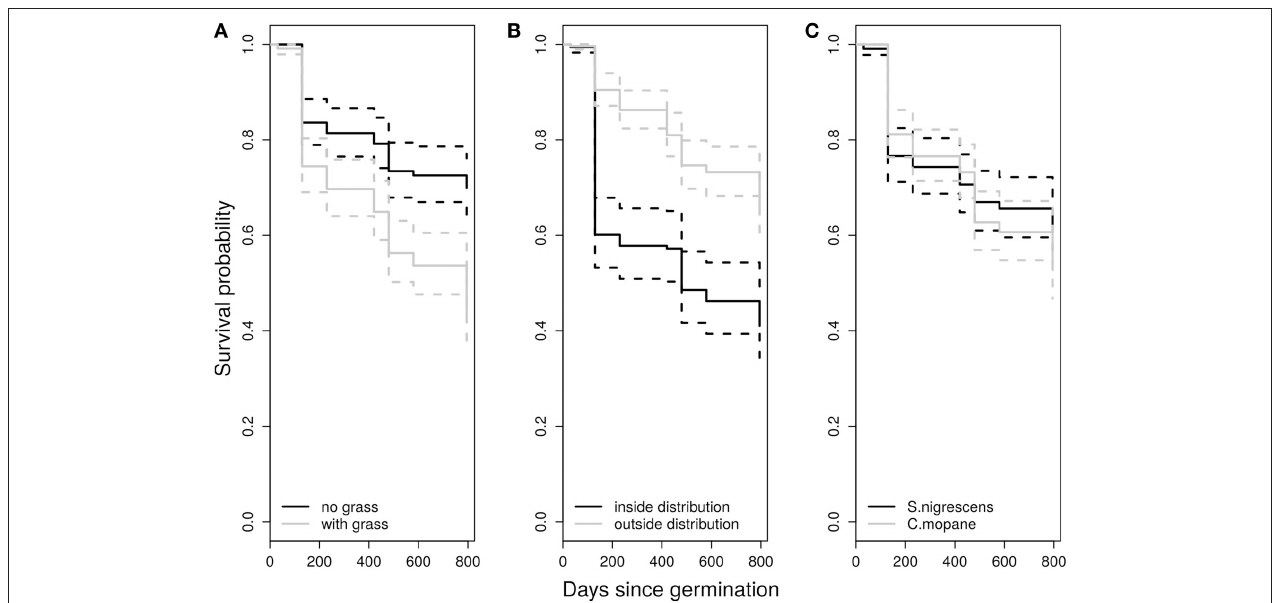
FIGURE 3 | Kaplan-Meier estimates of survival for seedlings grouped into treatment classes (A) , inside and outside their distribution range (B) , and by species (C) . Survival curves in figure were not weighted (alpha =